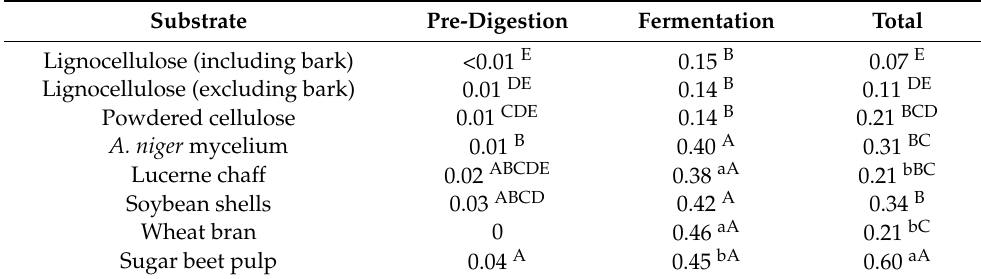
Table 10. Least squares means of in vitro organic matter digestibility coefficients after enzymatic pre-digestion, batch-culture fermentation (without pre-digestion), and in total (after fermentation of pre-digested